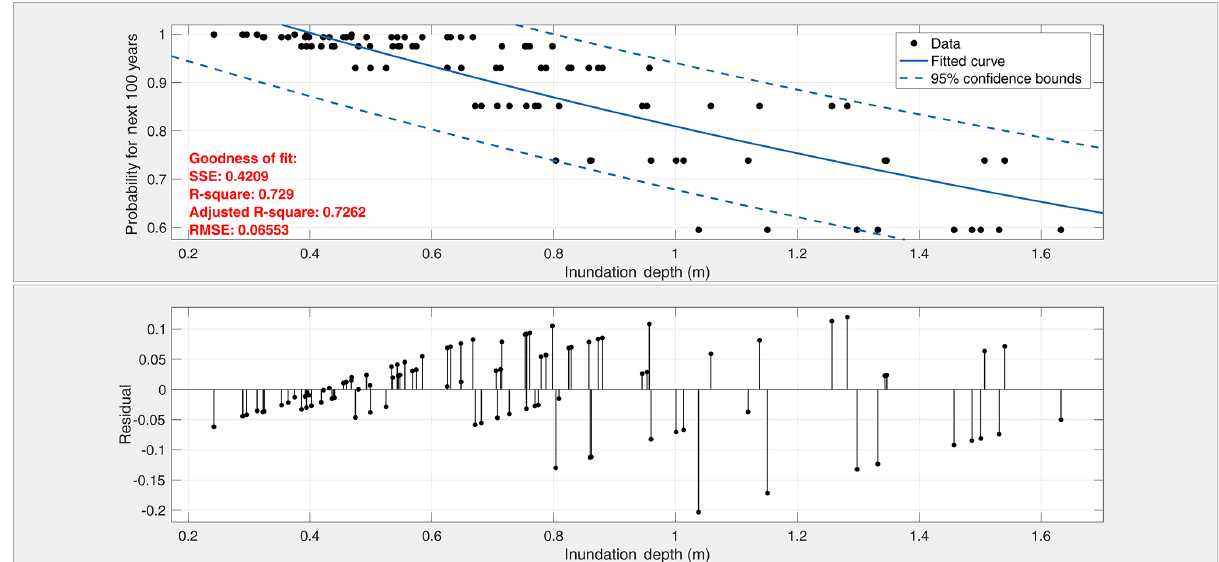
Figure 7. Probabilities of exceedance corresponding to maximum water surface elevation, minimum water surface elevation, and inundation depth for the next 100 years. Black dots represent the probability of exceedance of the tsunami hydrodynamic parameter for each event in the catalog. The blue line is the best fit curve to the data and the dashed blue line is the 95% confidence boundary of the fitted curve. The residual of the fit is represented for each probability